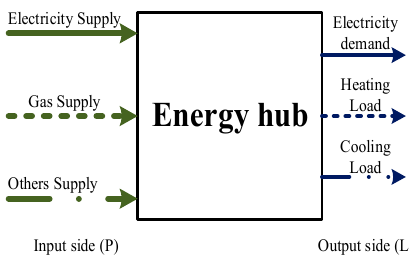
Figure 1. Energy hub